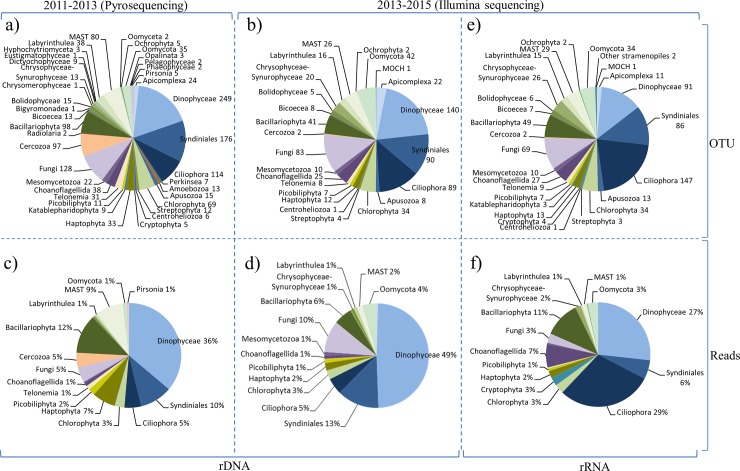
Overview of microbial community structure in the EEC, relative to the studied periods and sequencing methods.Number of OTUs unveiled by pyrosequencing (a) and Illumina (b) methods, and relative number of reads obtained by pyro-sequencing (c) and Illumina (d) methods, based on rDNA sequencing. Number of OTUs (e) and relative number of reads (f) based on rRNA Illumina sequencing. To facilitate reading, the percentage of reads number assigned to a specific group is given when ≥ 1%. Taxonomic affiliation was based on BLASTN searches against the PR2 and Silva databases.